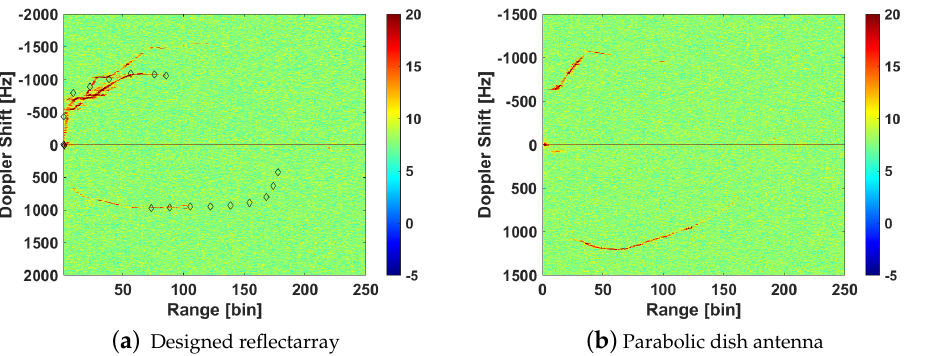
Figure 16. Cumulative RD maxima from results of trials in scenario 1 employing the designed reflectarray and commercial parabolic dish antenna in the surveillance channel.